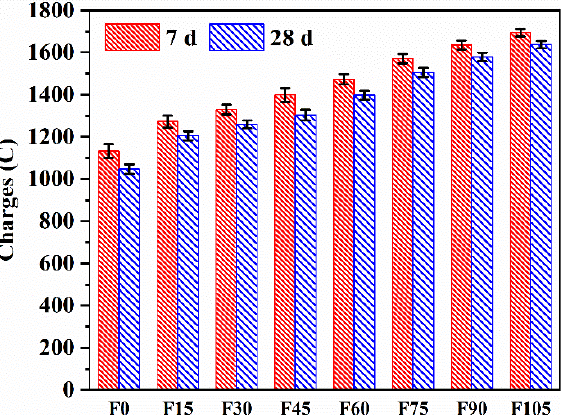
Figure 10. Total charges passed of F0–F105.